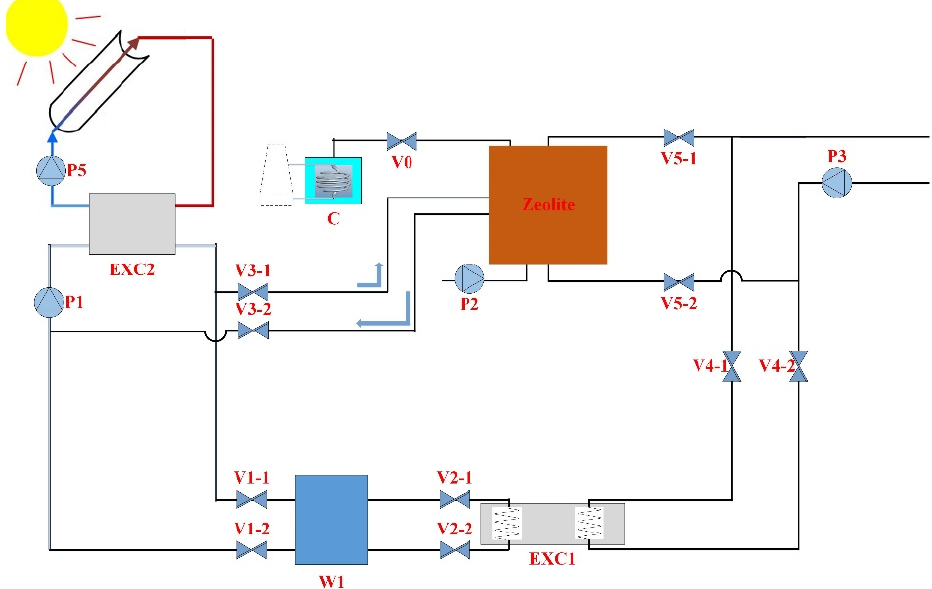
Figure 11. The conventional solar-heating system with STES based on zeolite water. The operating conditions of the proposed and reference systems are listed in Table 6. Table 6. Operating conditions of the proposed and reference systems.